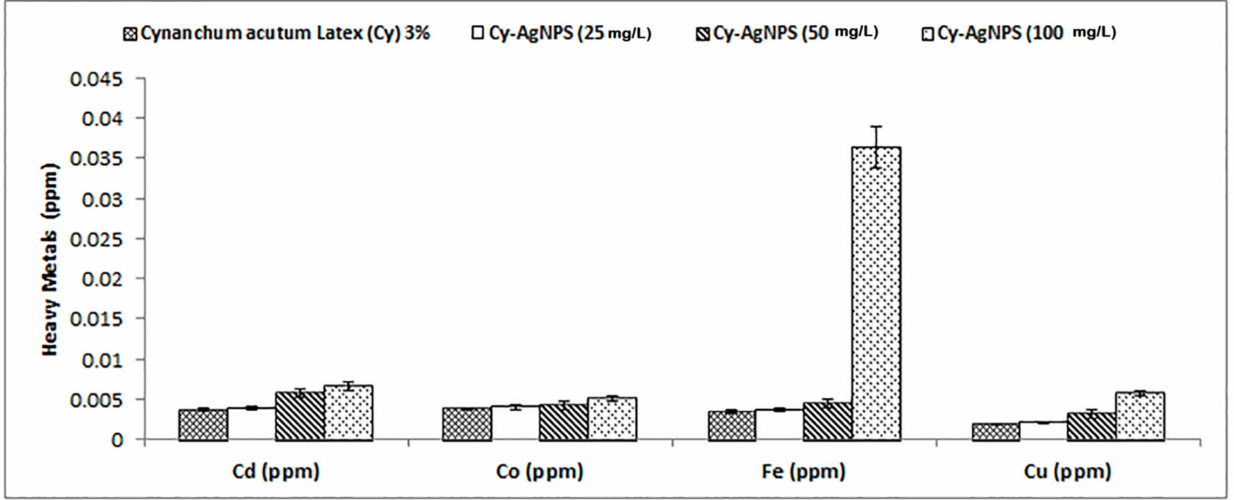
Figure 5. Different heavy metals in C. acutum Latex and its different nanoparticle concentrations.